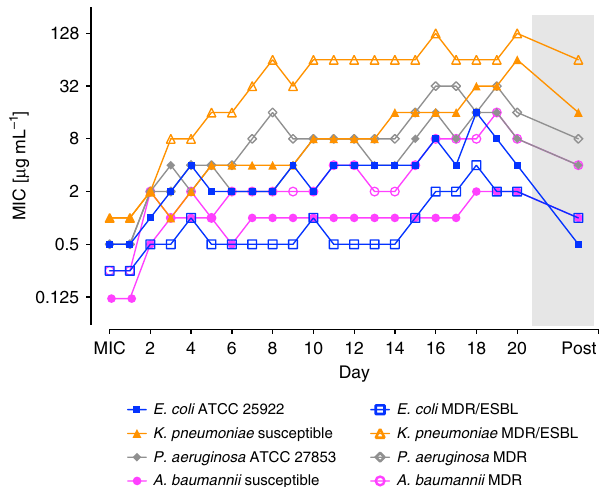
Fig. 3 Serial passage resistance induction of AA139 against susceptible and MDR Gram-negative bacteria. MIC values for AA139 before and after each of 20 passages (1 passage per 24 h, n = 1) treated with 0.5× MIC μ g mL − 1 (of previous passage). Bacteria that grew at the highest concentration of AA139 on the fi nal passage were passaged a further 3 times on drug-free agar plates before determining the fi nal MIC by BMD ( “ Post ” , gray shading). Tabulated MIC values for AA139 and arenicin-3 are presented in Supplementary Table 7. Strains used in this study are detailed by ( # ) in Supplementary Data